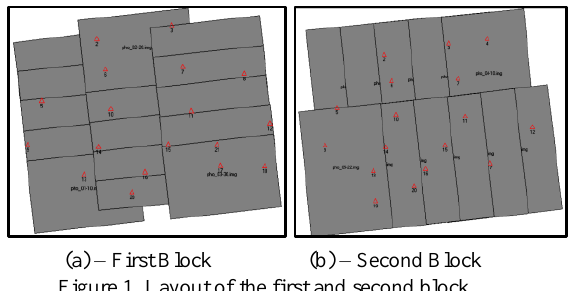
Figure 1. Layout of the first and second block